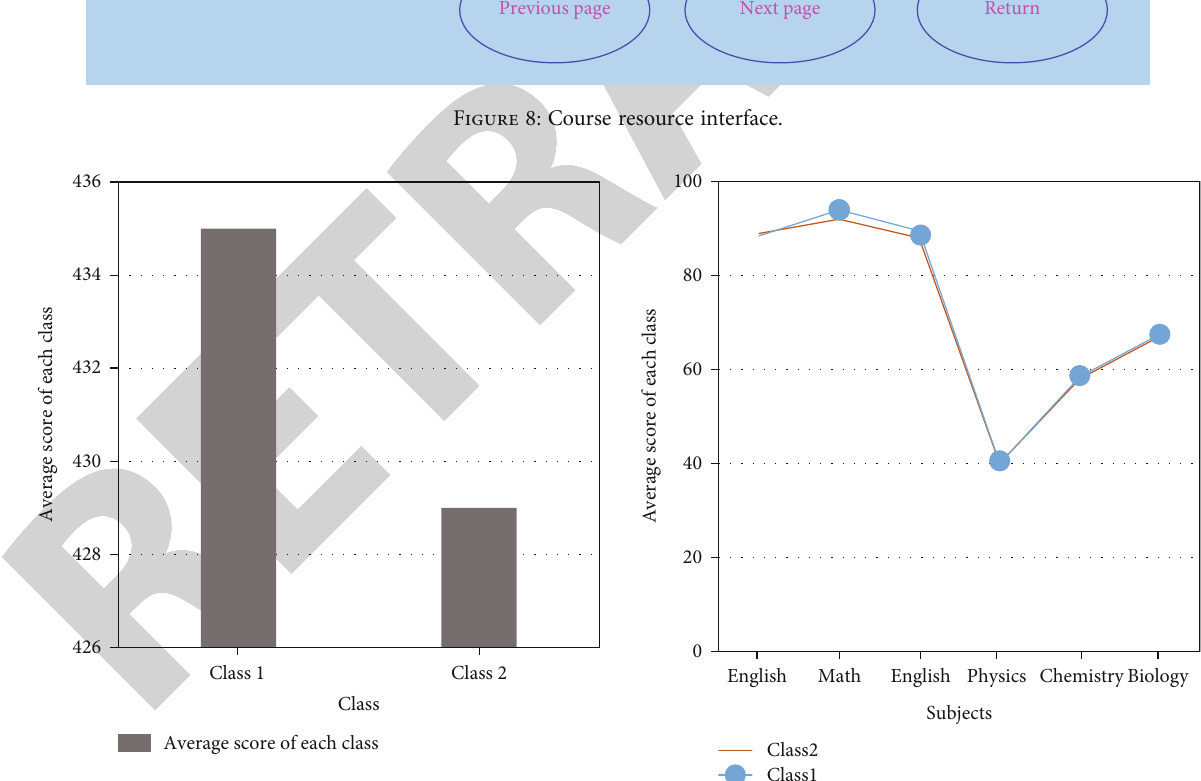
Figure 8: Course resource interface.